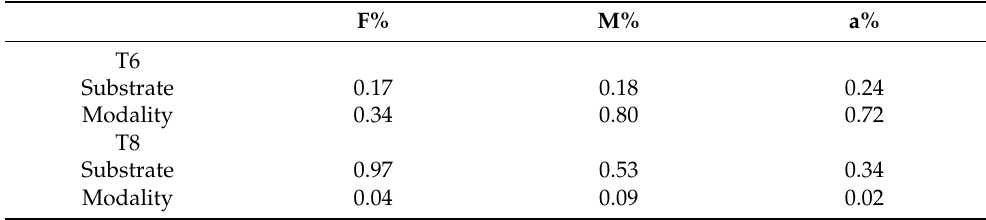
Table 3. Probabilities obtained with one-way ANOVA ( p -value threshold 0.05) performed on mycor- rhization rates (F%, M% and a%) at T6 and T8 considering substrates used in one hand and modalities in the